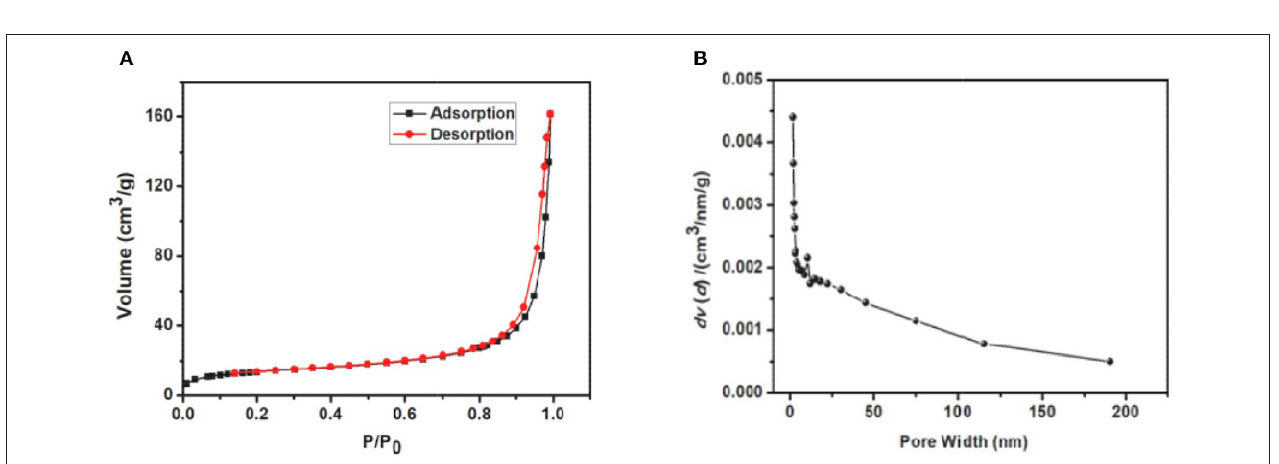
gradually occupied and blocked, the adsorption rate slowly paced down from 24 to 96 h; finally, the saturation of iodine adsorption over JLUE-COP-3 reached at 120 h. Furthermore, when the initial concentration varied from 100 to 300 mg/L, the